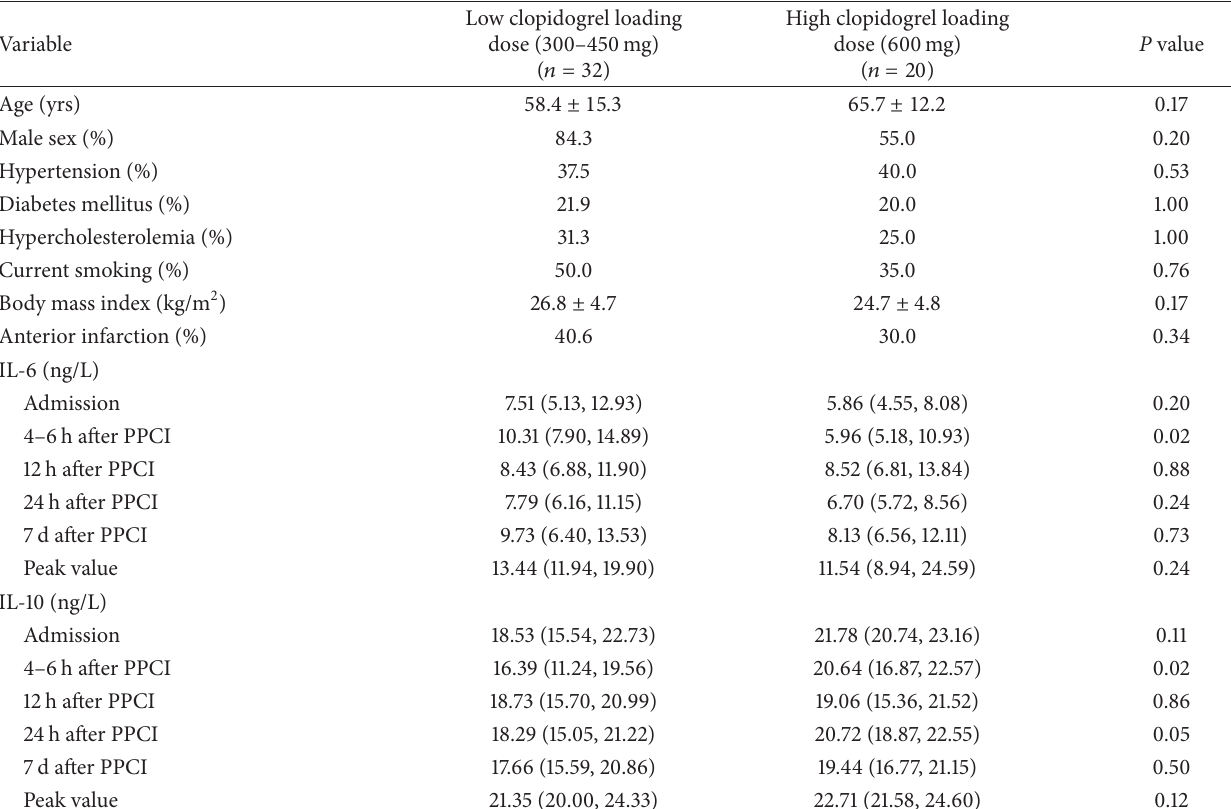
Table 2: Baseline characteristics and IL-6 and IL-10 levels in a subgroup.